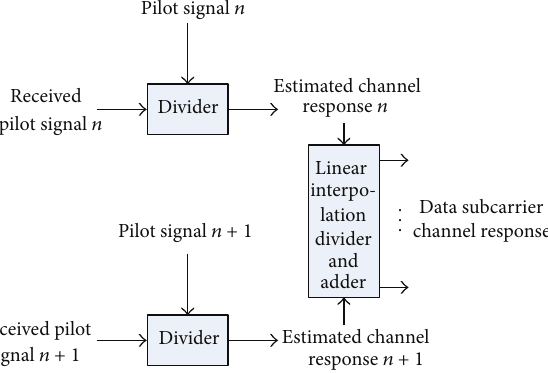
Figure 16: The circuit diagram of channel